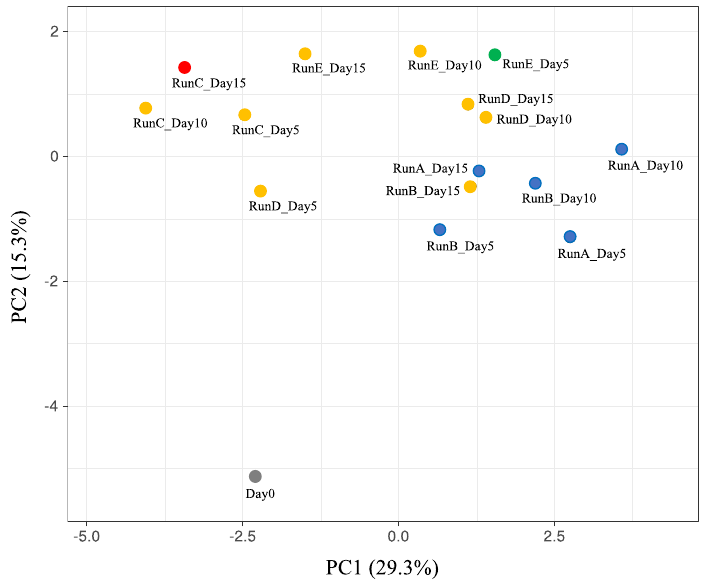
Figure 3. Principal component analysis of the taxonomic compositions among the batch cultures. Annotated numbers of operational taxonomic units (OTUs) were log-transformed. Unit variance scaling was applied to rows; singular value decomposition with imputation was used to calculate principal components. Samples were also clustered using correlation distance and average linkage, and the plots belonging to same clusters are indicated by same colors.